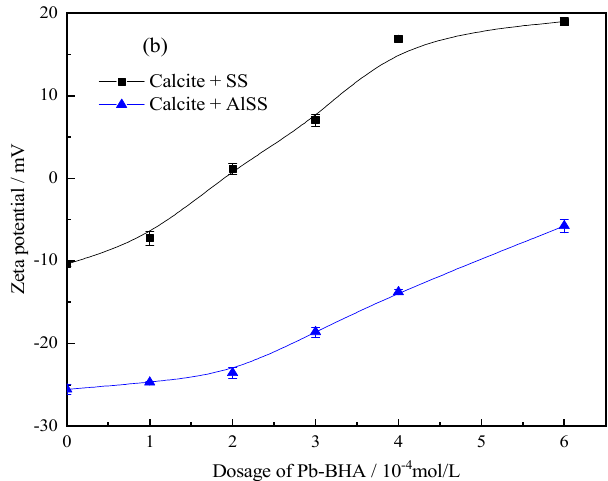
Figure 12. Zeta potential plots for ( a ) scheelite and ( b ) calcite at different concentrations of Pb-BHA after treatment with Na 2 SiO 3 and the Al-Na 2 SiO 3 polymer (pH = 8.0 ± 0.1, C Pb : C BHA = 2, C SS = C AlSS = 100 mg/L).